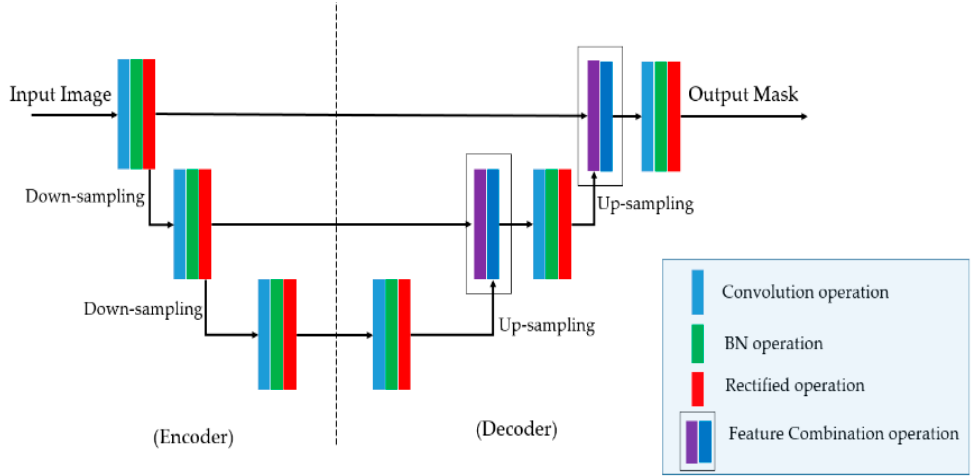
Figure 3. Conceptual diagram of proposed suggestion network (SN).